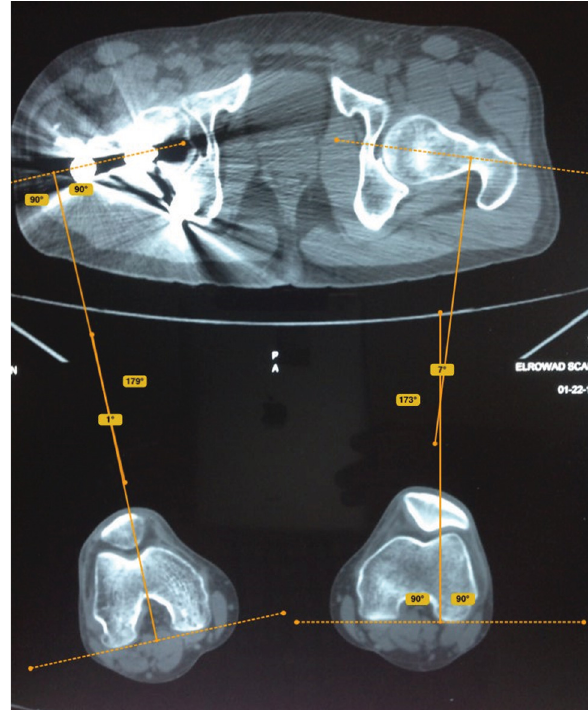
Figure 4. Measurement of anteversion angle on the fractured and healthy side by Bone Ninja application; a difference between both anglesisexpressedasrotationalmalalignment.Ontheinjuredright side, there is a difference in the rotation angle of 6 ° (decrease in the angle means external rotational malalignment of 7 ° (cid:3) 1 ° =6 °